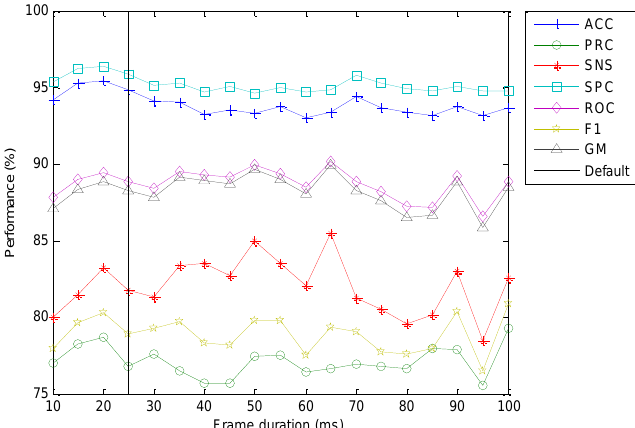
Figure 22. Classification performance metrics of the best classifier vs. the frame duration.